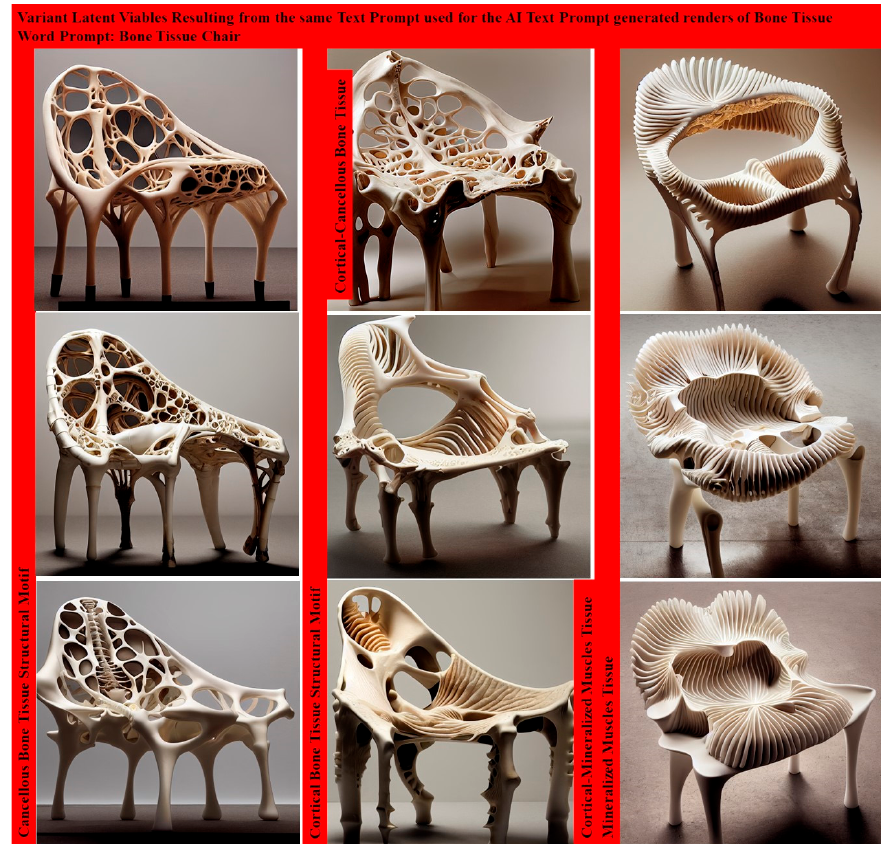
Figure 2. The bone chair biomineralization research project: AI text-prompt-generated latent variables of bone tissue chair variations between cancellous, cortical, and mineralized muscle tissue). It exhibits success in learning the data patterns from two distinct disciplines (histology/anatomy and furniture design) due to the sufficient training data obtained from the previous literature, especially in high-end characterization advanced microscopy studies of bone tissue hierarchical structural